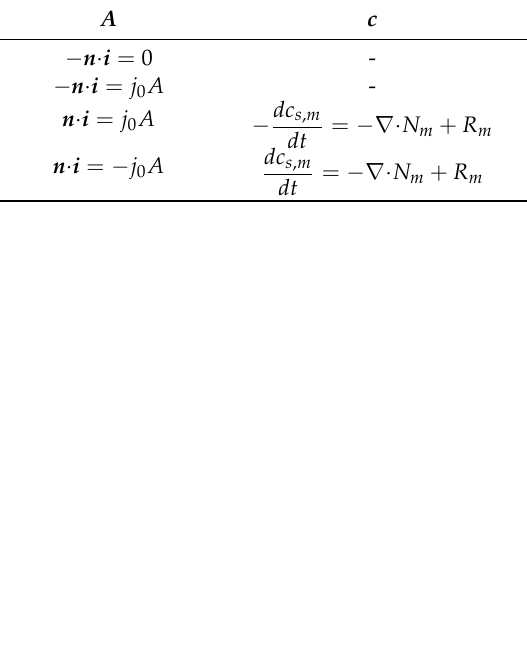
Figure 3. Geometric model and mesh of electrodeposition. Table 3. Boundary